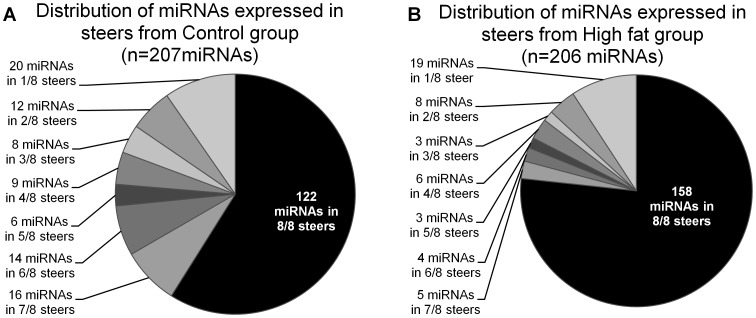
Distribution of miRNAs detected in steers fed control diet (A) or high fat diet (B). The distribution of miRNAs considers data from both subcutaneous and visceral fat tissue for Control (A) and High fat diet (B) groups. Each pie chart represents how the total amount of miRNAs (Control = 207, High fat = 206) are distributed within the animal population of each group, varying from a maximum of eight out of eight animals to a minimum of one out of eight.